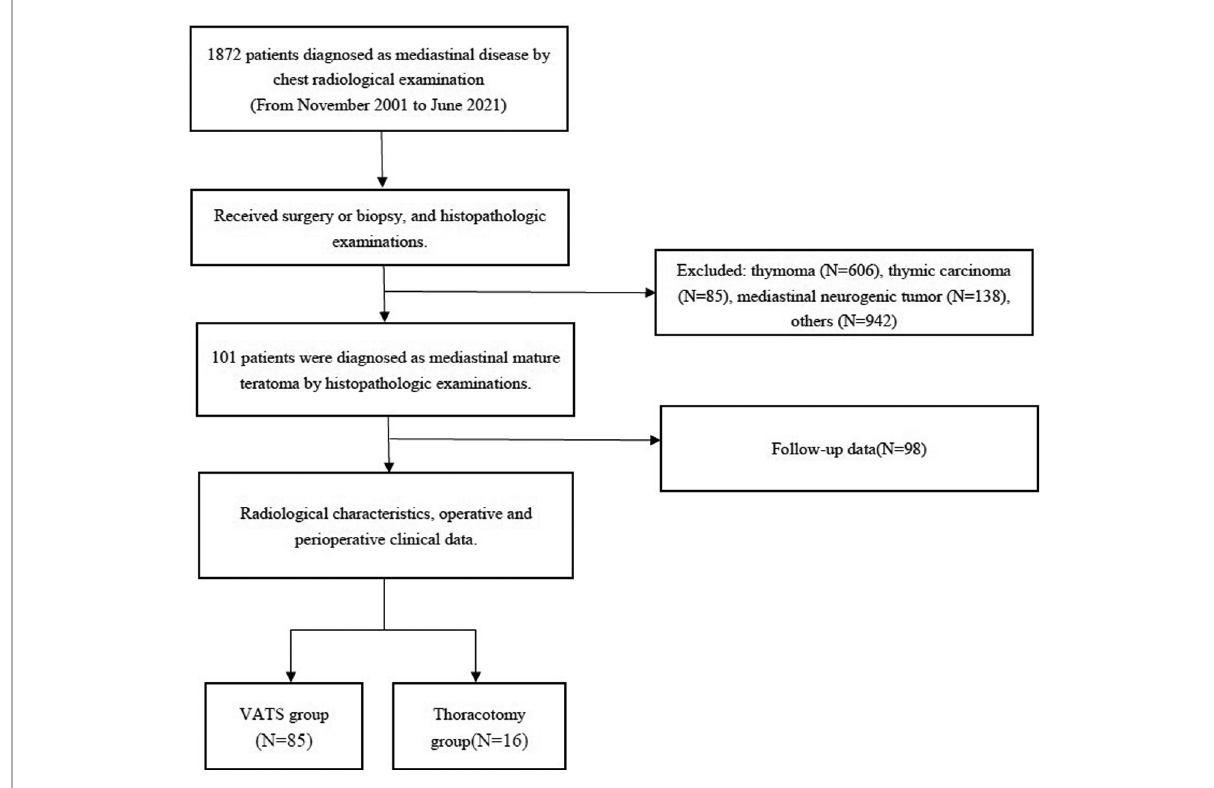
FIGURE 1 Flow diagram for the patient selection included in this